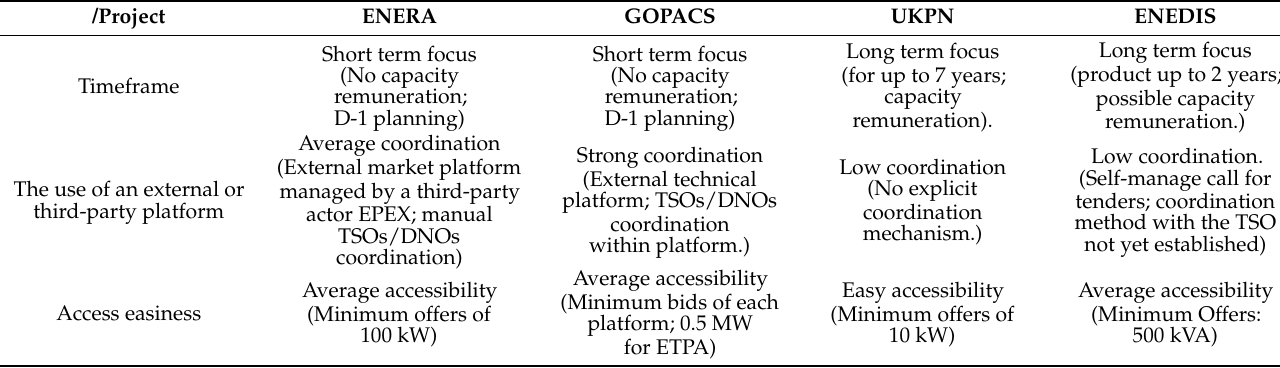
Table 3. Summary of the main features of the different